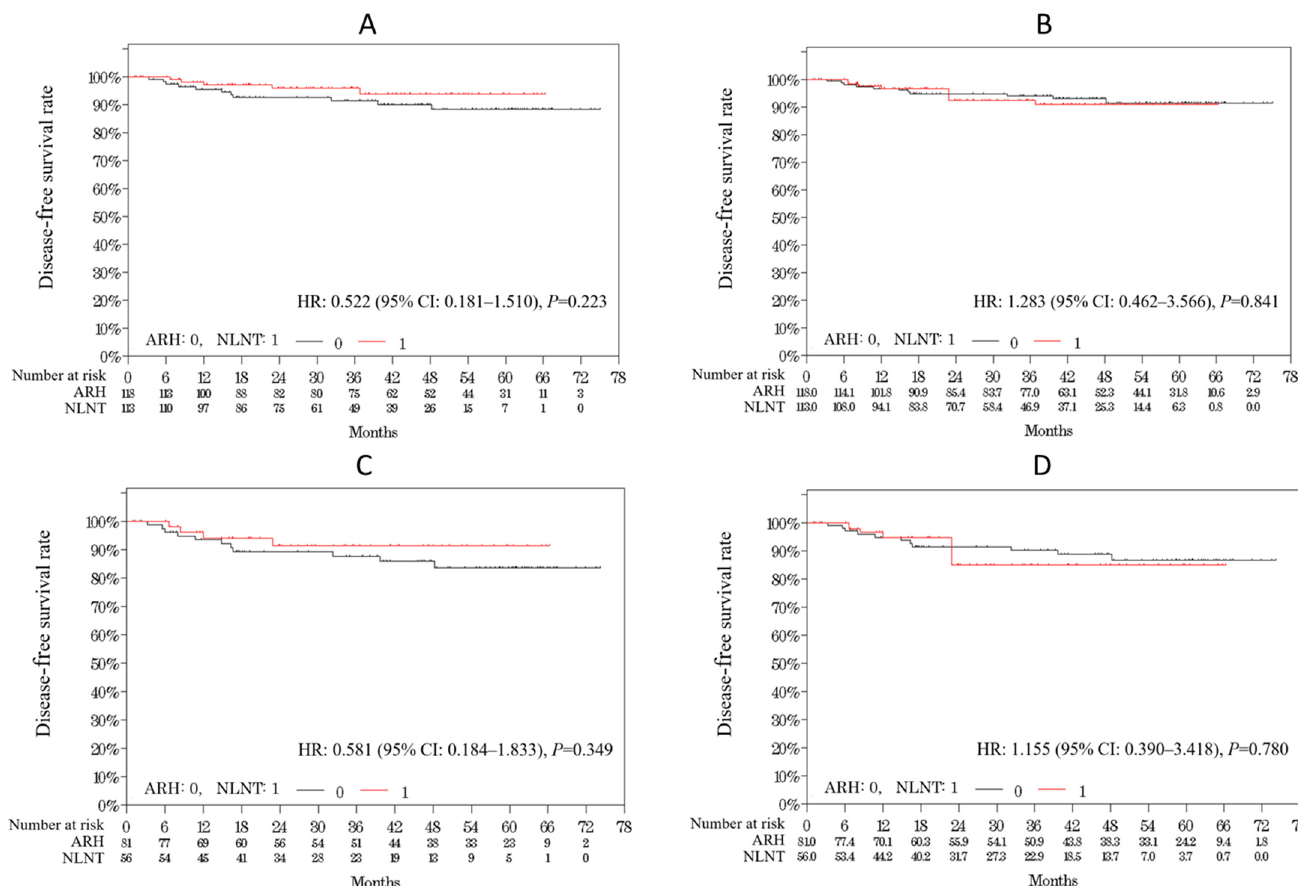
Figure 2. Kaplan–Meier survival analyses in patients with early stage cervical cancer who underwent ARH vs. LRH using NLNT. ( A ) Raw data of disease-free survival for all patients. ( B ) IPTW-adjusted data of disease-free survival for all patients. ( C ) Raw data of disease-free survival for patients with tumor size >2 cm in diameter. ( D ) IPTW-adjusted data of disease-free survival for patients with tumor size > 2 cm in diameter. ARH—abdominal radical hysterectomy; NLNT—laparoscopic radical hysterectomy using no-look no-touch technique; IPTW—inverse probability of propensity score weighted; HR—hazard ratio; CI—confidence interval.